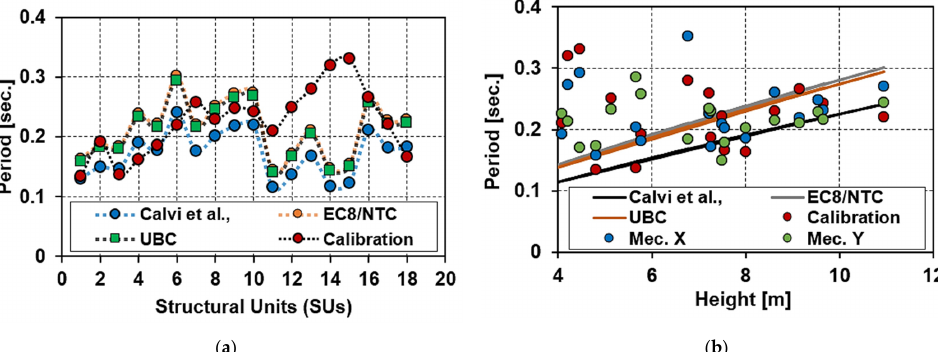
Figure 18. Comparison among different formulations to estimate vibration periods of investigated SUs ( a ) and period vs. height trends obtained from theoretical relationships and mechanical analyses ( b ).